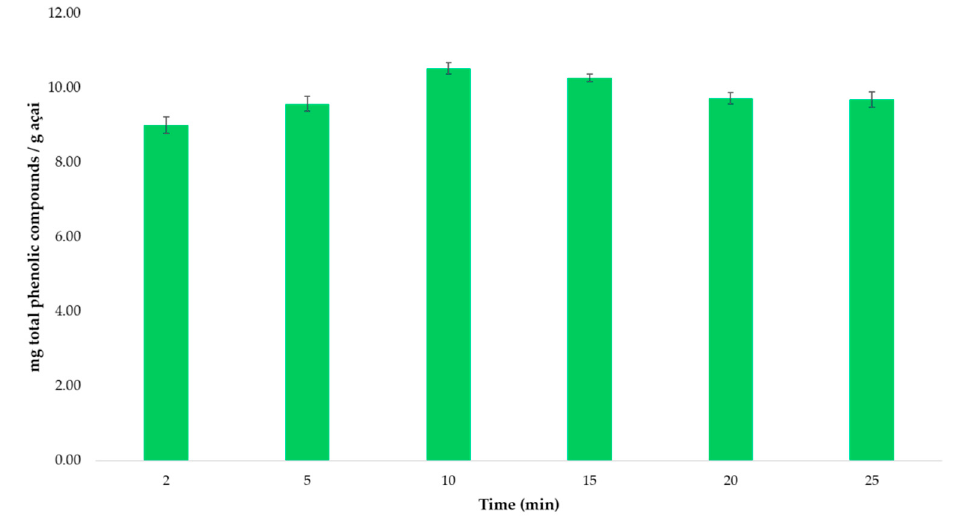
Figure 5. Milligrams of total phenolic compounds recovered per gram of açai recoveries during the kinetics study.